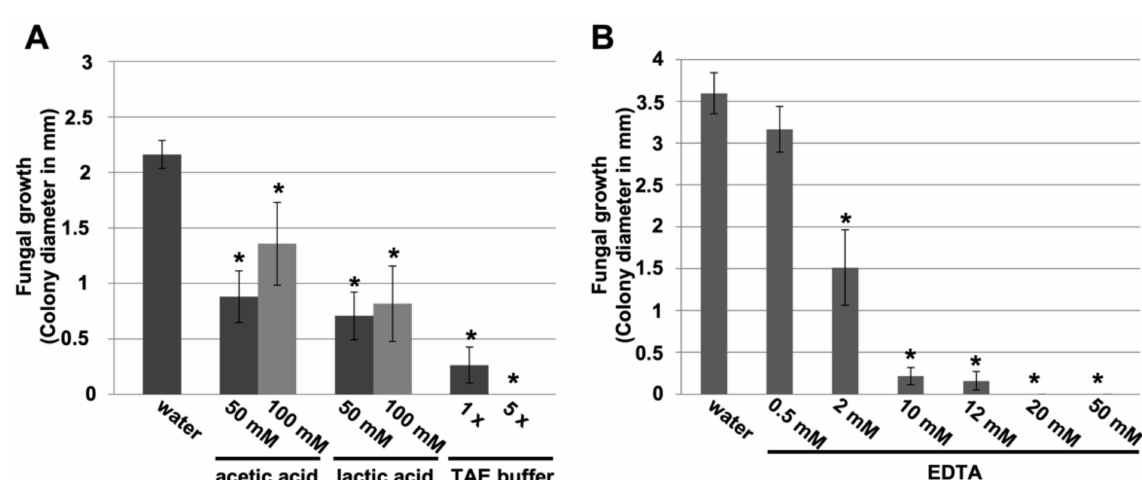
Figure 3. Disease-suppressing effect of carboxylic acids against cucurbit powdery mildew. Melon cotyledon discs were treated with the different compounds and inoculated with P. xanthii as described in the Materials and Methods. Powdery mildew symptoms expressed as the P. xanthii colony diameter (in mm) were recorded 12 d after pathogen inoculation. ( A ) Initial trials with acetic acid, lactic acid, and TAE (Tris-acetate-EDTA) buffer. ( B ) Trials only with EDTA. Data represent the means of ten samples from two independent experiments, with error bars representing the standard error. The asterisks indicate a statistically significant difference between the treatment and the negative control (water) according to an LSD test ( p = 0.05). See Figure S2 for representative